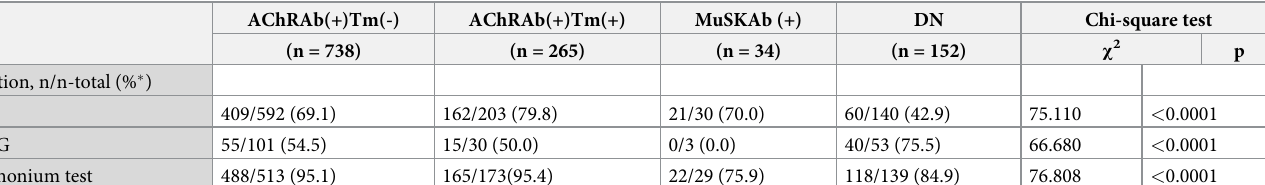
Table 5. Examination to evaluate NMJ function.